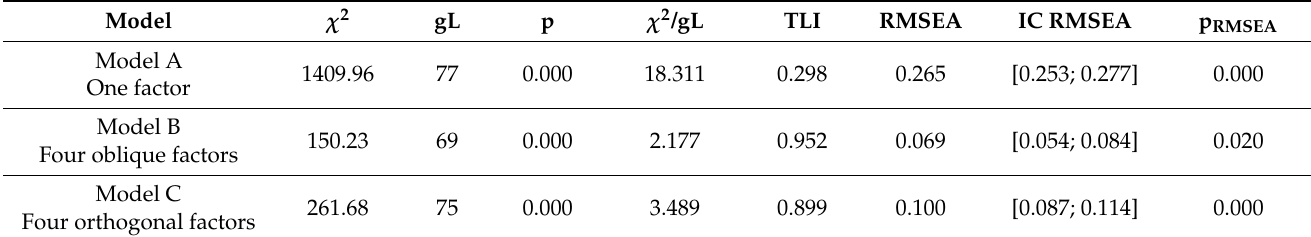
Table 4. Goodness-of-fit indices for the